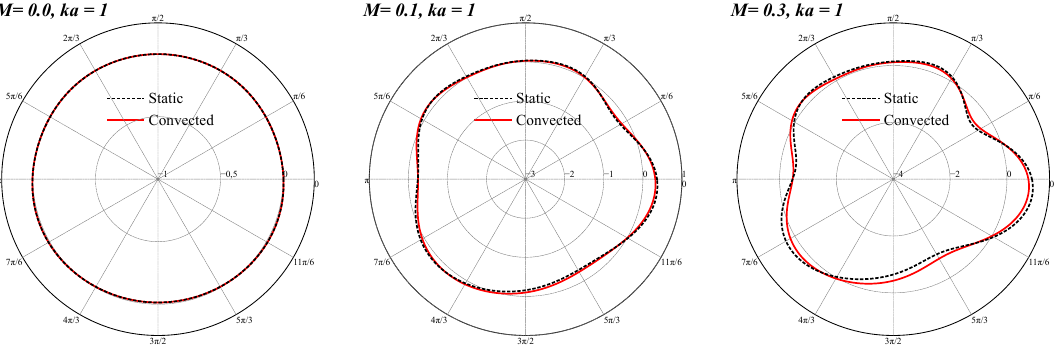
Figure 8. Directivity pattern at r = 5 R 2 of the insertion loss I M b =